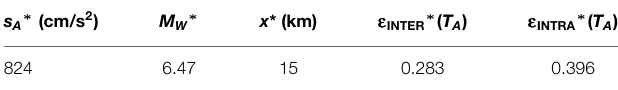
larger than that of item A when ρ = 0, while it is 1.1 times larger when ρ = 0.6. The median capacity decreases as the correlation coefficient ρ increases because of simultaneous damage of two items.AsforcaseSwhereanadditionalseismicmarginisprovided to item B, the median capacity of the system is 1.5 times larger than that of item A when ρ = 0, 0.3, and 0.6. The difference between ρ can be observed for ground motion <2,000 cm/s 2 . As for case T, the case that the natural period of item B is elongated, the median capacity of the system is 2.1 times larger than that of item A, while the logarithmic standard deviation is 0.47, and this is larger than those in case 0 (0.24–0.28) and case S (0.26–0.30). Case T is more effective for larger ground motion levels as compared to cases 0 and